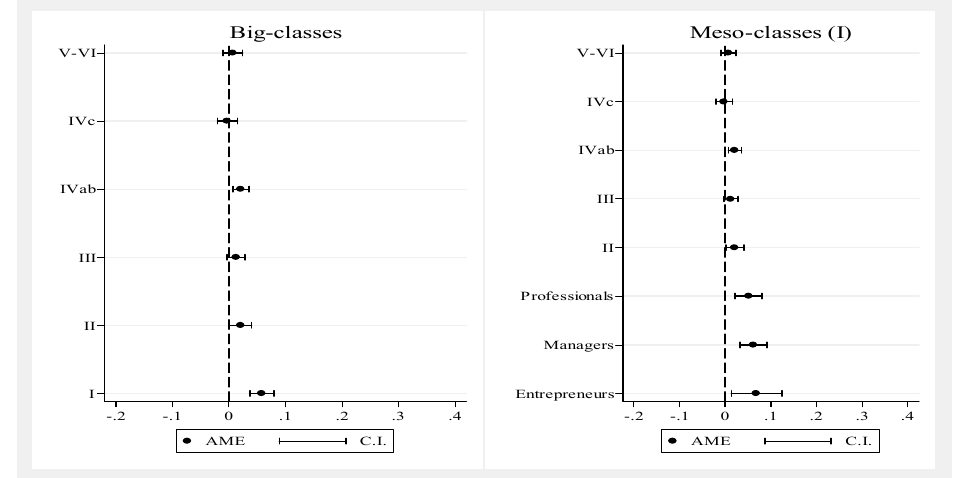
Figure A2. Average marginal effects from logistic regression models for the probability of being in the higher service class according to big- and meso-classes (ref. cat. working-class VII). Estimates are at net of controls (gender, geographical areas, cohort of birth, and education). Black dots denote the AME of social classes for men, and the gray triangle for women and black lines denote 95% confidence intervals. Legend: higher service class (I), lower service class (II), routine non–manual workers (III), petite bourgeoisie (IVab), farmers (IVc), skilled manual workers (V–VI). Source: ILFI (1997–2005).